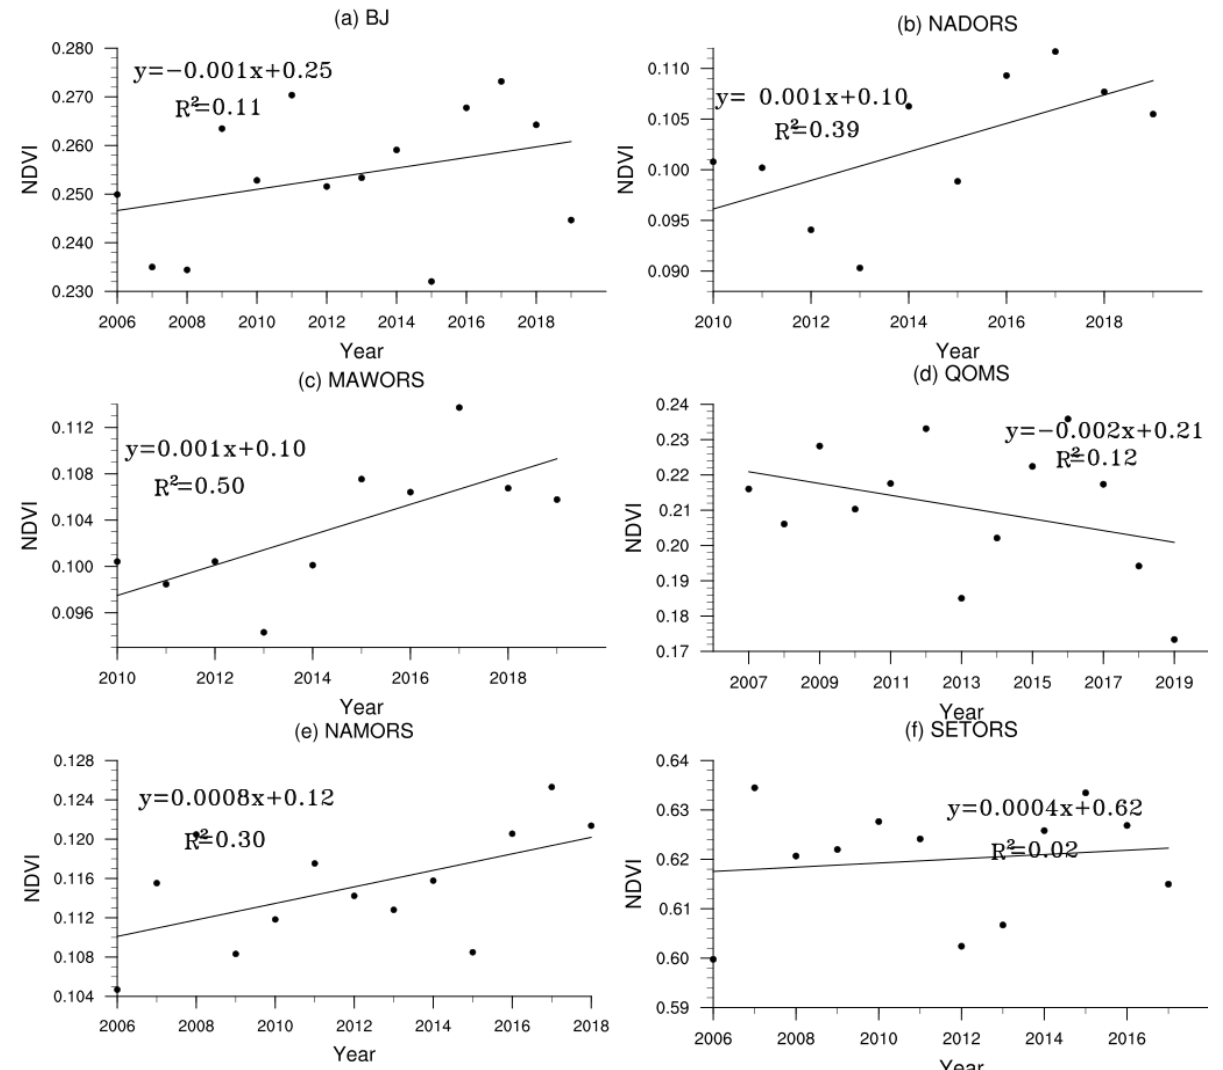
Figure 10. Interannual variation of NDVI at each station. The annual variation of upward shortwave radiation (Figure 8a) showed trends at MAWORS and SETORS that were broadly consistent with those of downward shortwave radiation. There were notable annual variations in upward shortwave radiation at BJ, QOMS, NAMORS, and NADORS. In spring, the trend generally followed that of downward shortwave radiation. In summer, NDVI increased (Figure 11), vegetation became lush, and the ground absorbed more downward shortwave radiation, while the ground received less shortwave radiation. Therefore, the upward shortwave radiation decreased. In autumn, the air temperature dropped below 0 ◦ C (Figure 12a), due to snow accumulation on the ground, an increasing trend of upward shortwave radiation was observed, especially at NAMORS, where the upward shortwave radiation in November reached 160 W · m − 2 . In winter, the area of snow on the ground remained largely unchanged, thus the upward shortwave radiation flux decreased with the decreasing solar altitude